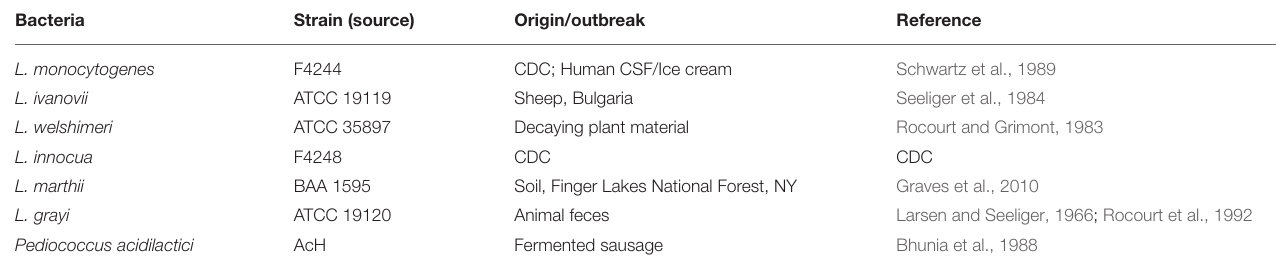
TABLE 1 | Bacterial strains used in this